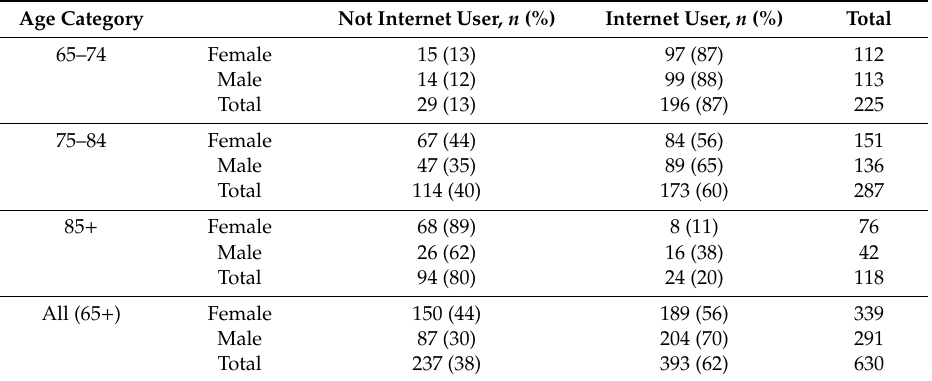
Table 3. Age and gender distributions among the users and non-users.